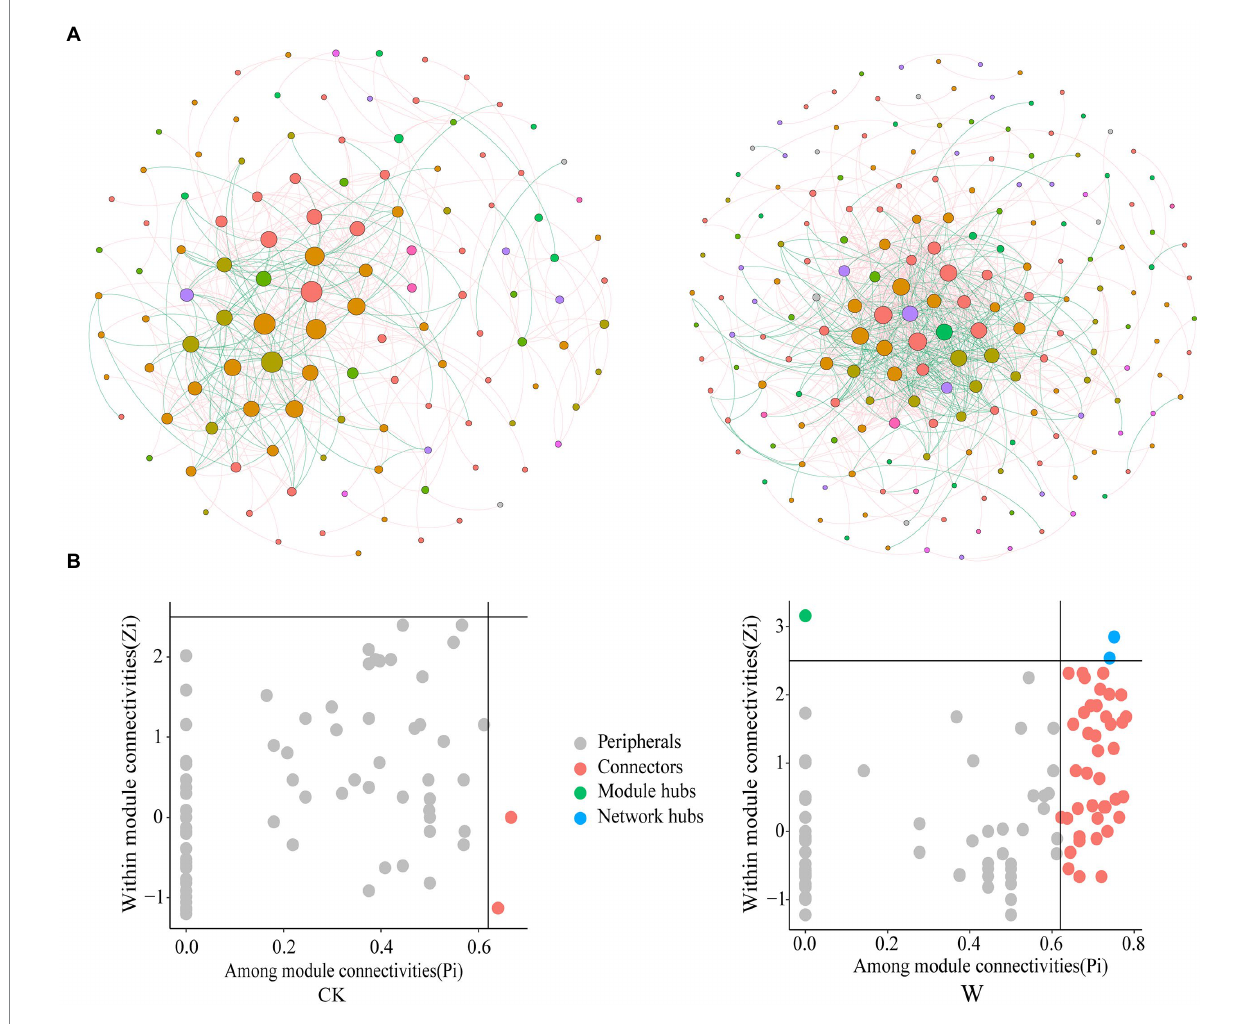
FIGURE 4 The bacteria network and biomarkers under control and warming. (A) Microbial co-occurrence networks under control and warming. The thickness of the edges is proportional to the value of the Spearman’s correlation coefficient, and the size of the nodes is proportional to the degree of the OTUs. (B) Roles of nodes based on their Zi and Pi values in the co-occurrence